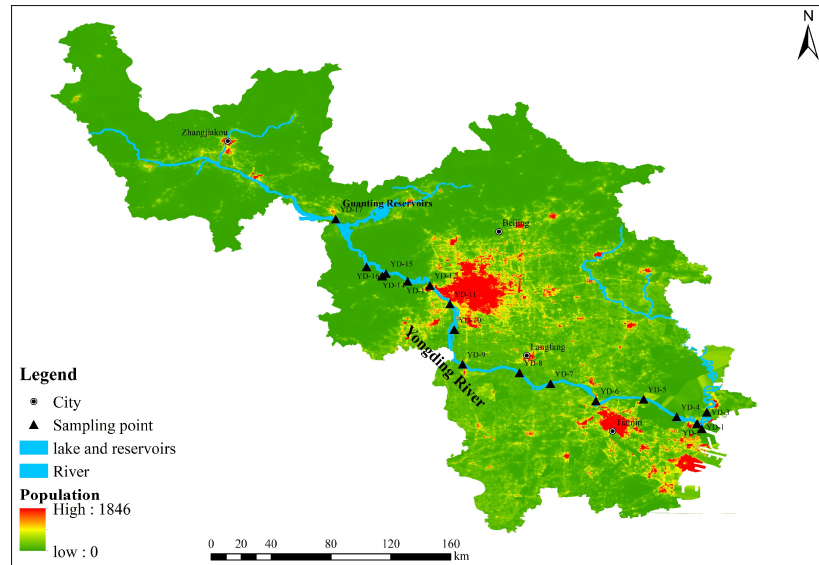
Figure 5. Population density in the Yongding River basin.